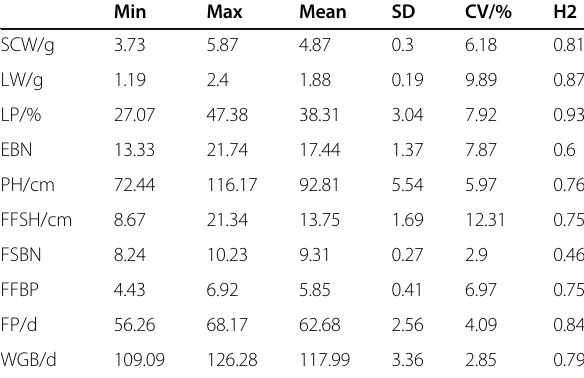
Table 1 Statistics of cotton yield-related traits in the 503 upland cotton germplasm